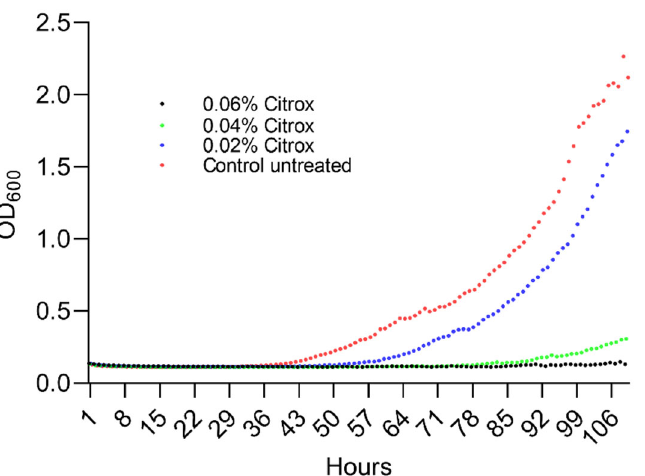
Figure 1. The impact of Citrox CBL on growth and survival of L. pneumophila at concentrations of 0.02–0.06%. The MIC concentrations tested are indicated on the graphs in order to establish the sub-inhibitory concentration for further investigations. The experiments were performed in triplicate and on three separate occasions. In order to quantify the growth, the absorbance was measured at 600 nm every 3 h for 36 h.